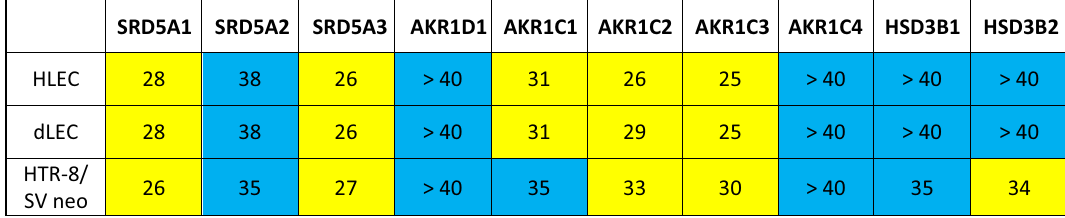
Table 3. Gene expression analysis in HLEC, dLEC and HTR-8/SVneo. mRNA expression of enzymes involved in progesterone metabolism in HLEC, dLEC and HTR-8/SV neo. Expression levels are shown as ct values per 12.5 ng cDNA. Yellow: significant expression (ct < 35). Blue: no or very low expression (ct ≥ 35). SRD5A1 (5α-reductase isoform 1), SRD5A2 (5α-reductase isoform 2), SRD5A3 (5α-reductase isoform 3), AKR1D1 (5β-reductase), AKR1C1 (20α-HSD), AKR1C2 (3α-HSD3), AKR1C3 (HSD17B5), AKR1C4 (3α-HSD1), HSD3B1, HSD3B2. Appropriate positive and negative controls were run.